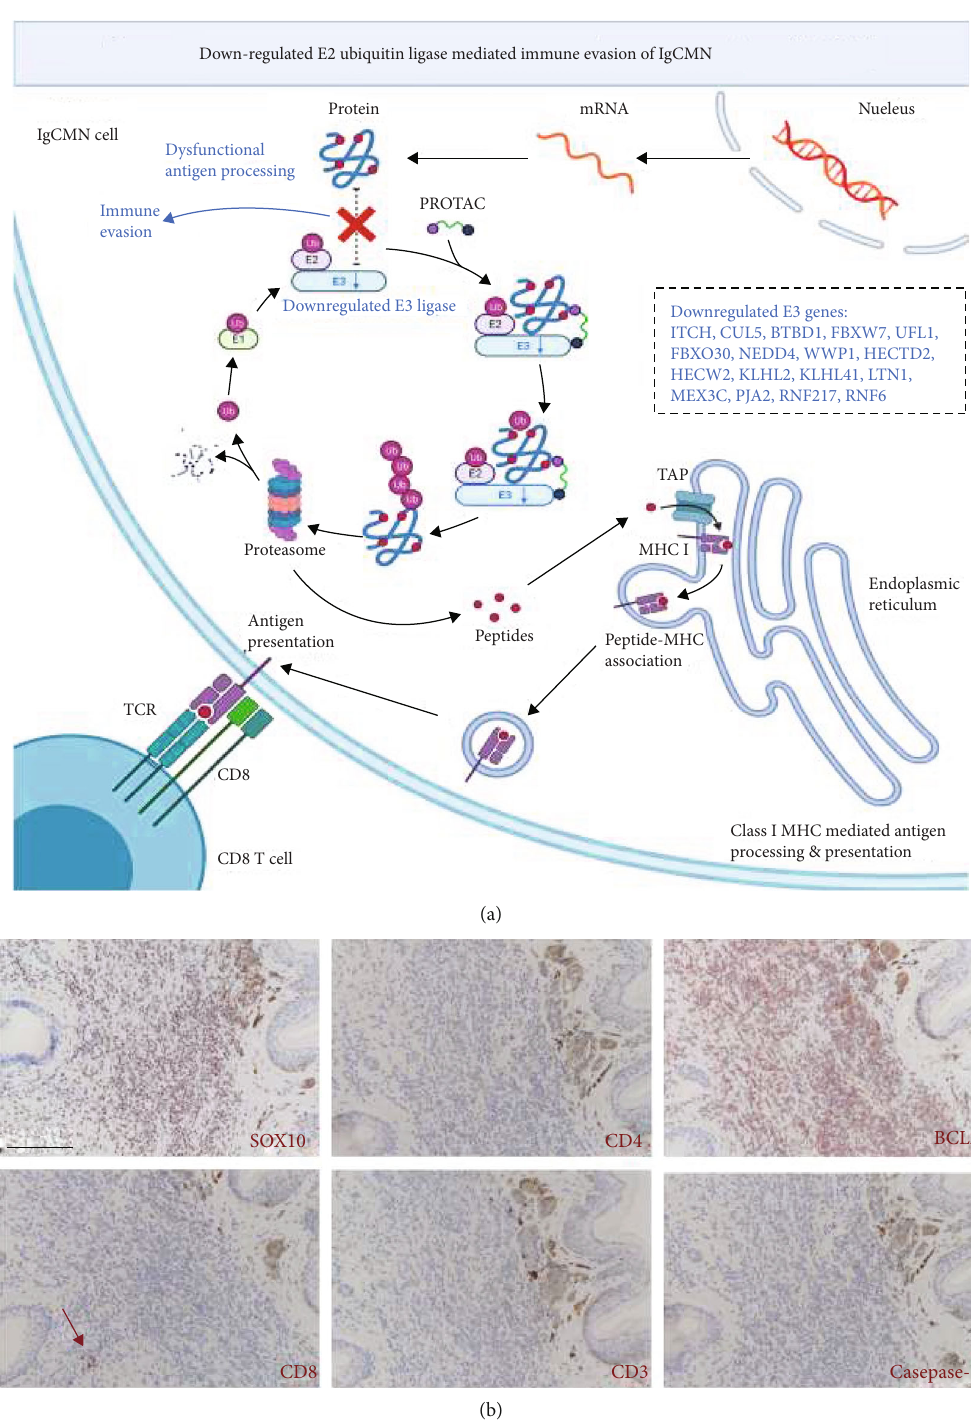
Figure 5: Immune evasion in lgCMN. (a) Flow chart of MHC class I-mediated antigen processing and presentation. The abnormal parts are presented in blue fonts. The downregulated E3 ligase gene leads to the dysfunction of antigen processing in lgCMN, inducing immune evasion. This fi gure was created using BioRender. (b) De fi ciency of tumor-in fi ltrating lymphocytes in lgCMN tissues. Immunohistochemical staining for SOX10 (labeling lgCMN cells), CD3 (labeling mature T lymphocytes), CD4 (labeling helper T lymphocytes), and CD8 (labeling cytotoxic T lymphocytes) in lgCMN tissues ( n = 5 ; patient2 + patient 4 + patient5 + patient 9 + a lgCMN patient with halo phenomenon) was stained using the AEC chromogen to detect tumor-in fi ltrating lymphocytes. BCL2 (antiapoptosis related) and caspase-3 (apoptosis related) were stained using the AEC chromogen to investigate antiapoptotic activity. The red arrow points at a few CD8 + T cells far away from SOX10+ lgCMN